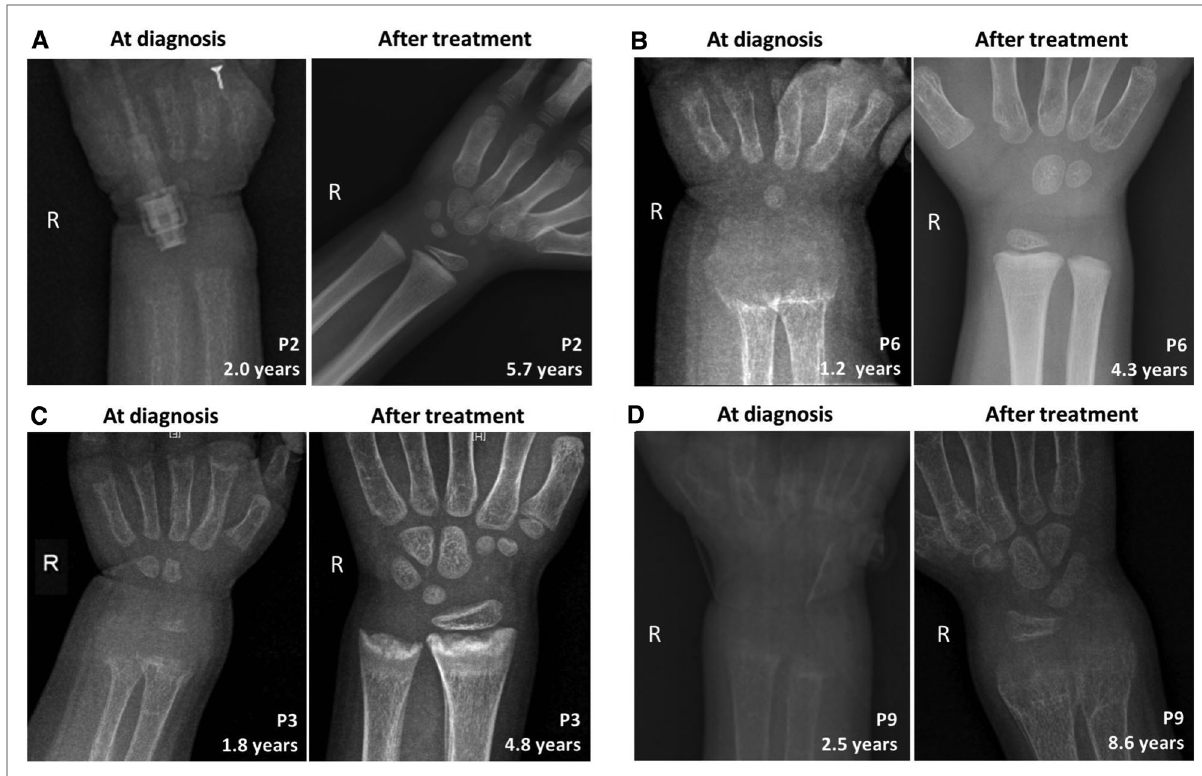
FIGURE 2 Comparison of skeletal x-ray images of four VDDR1A children at diagnosis and after treatment. In each panel, the left is the skeletal x-ray image at diagnosis, while the right is the image after treatment. P2 and P6 showed good compliance, while P3 and P9 showed poor compliance. ( A ) P2, ( B ) P6, ( C ) P3, and ( D )